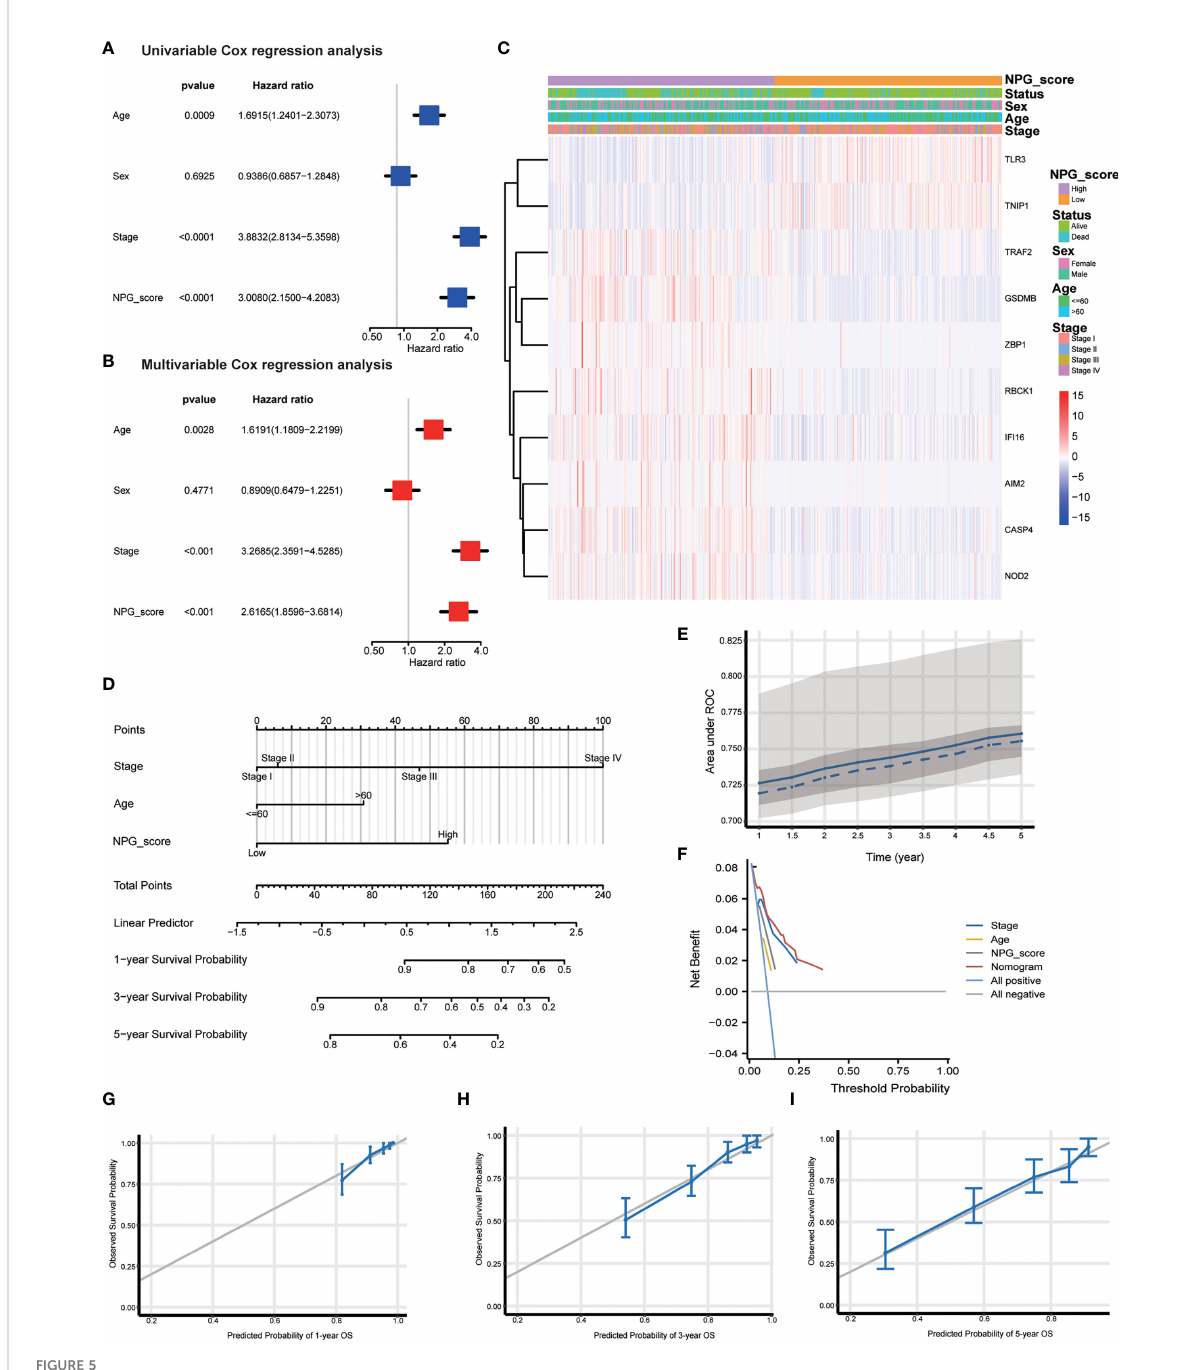
FIGURE 5 Independent prognostic validation and establish of nomogram. (A) Univariate cox regression for TCGA cohort based on the clinical characteristics (pathological stage, age, and sex) and NPG score. (B) Multivariate analysis for TCGA cohort. (C) Heatmap showing the clinicopathologic characteristics formed by 10 NPRGs and clinical features in low- and high- NPG score groups. (D) Nomogram. (E) ROC curves illustrating the prediction ef fi ciency of nomogram (AUC, 0.72 to 0.76). (F) DCA curves illustrating the clinical effectiveness of the nomogram. (G – I) Nomogram to predict 1-, 3-, and 5- year overall survival rates of ccRCC patients. Calibration plots showed overall survival nomogram model to compare the nomogram-predicted probability (blue line) with ideal nomogram (grey